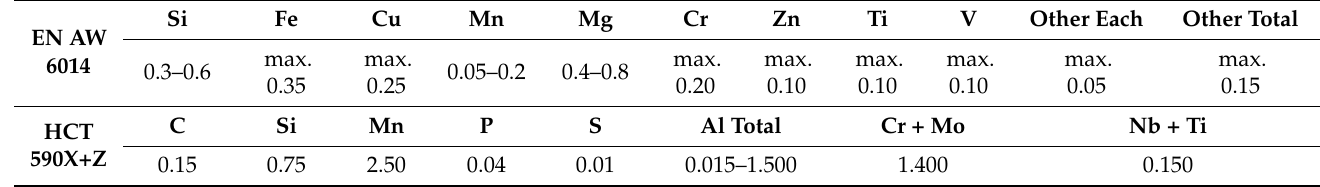
Table 1. Chemical composition of the joining materials EN AW 6014 [18] and HCT 590X+Z [19] in weight %. Si Fe Cu Mn Mg Cr Other Each Other Total EN AW max. 6014 0.3–0.6 C Si Mn P S HCT 590X+Z 0.15